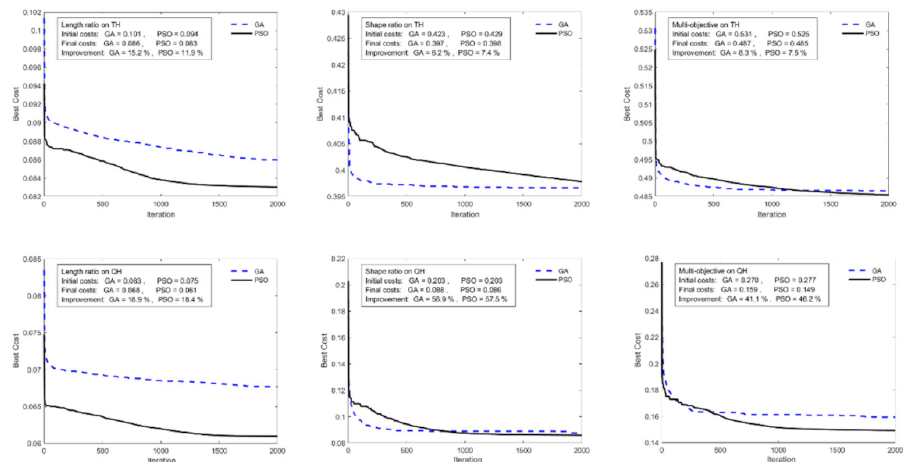
Figure 3. The particle swarm optimization (PSO) and genetic algorithm (GA) diagrams on Hemi- sphere gridshell considering different cost functions.